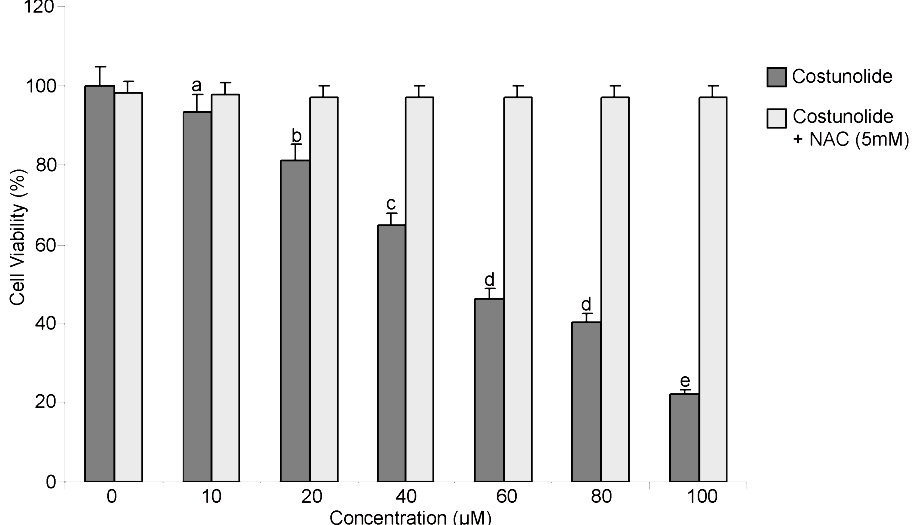
Figure 2. Costunolide inhibited the cell growth and induced cell death. T24 Cells were treated with indicated doses of costunolide in the presence or absence of NAC for 24 h and cell viability was measured by MTT assay. Data are expressed as Mean ± SD (n = 3). Columns not sharing the same superscript letter differ significantly ( p <